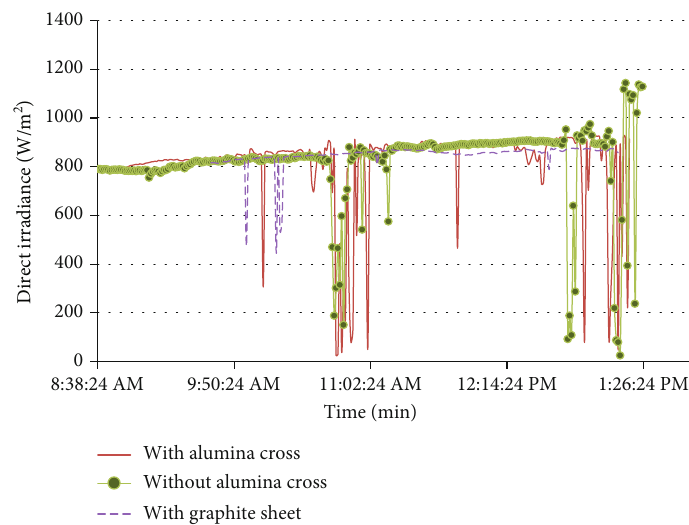
Figure 9: The direct sun irradiance during the HS study.